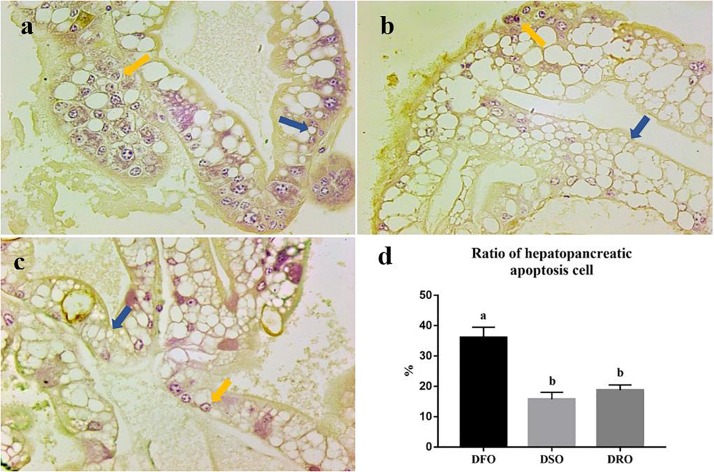
Hepatocyte apoptosis of Macrobrachium rosenbergii. (a) Prawns fed diet including 6% fish oil (DFO); (b) Prawns fed diet including 6% soybean oil (DSO); (c) Prawns fed diet including 6% rapeseed oil (DRO); (d) Ratio of hepatopancreatic apoptosis cell (n = 3). Blue arrow: normal cells; yellow arrow: apoptotic cells.